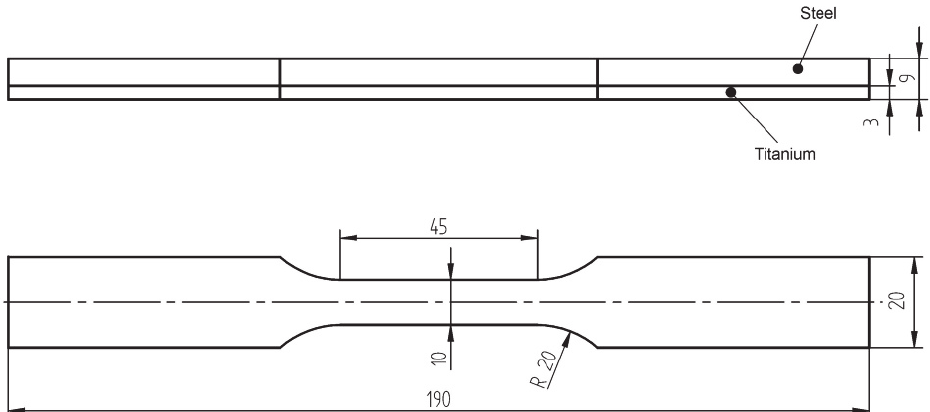
Figure 6: Shape and dimensions of the fatigue